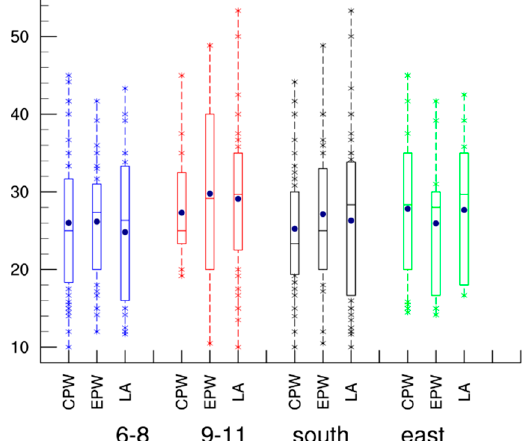
Figure 4. Same as in Figure 2, but for landfalling TCs intensity (m/s) during different seasons (summer, 6–8; autumn, 9–11) and over different landing locations (south and east).